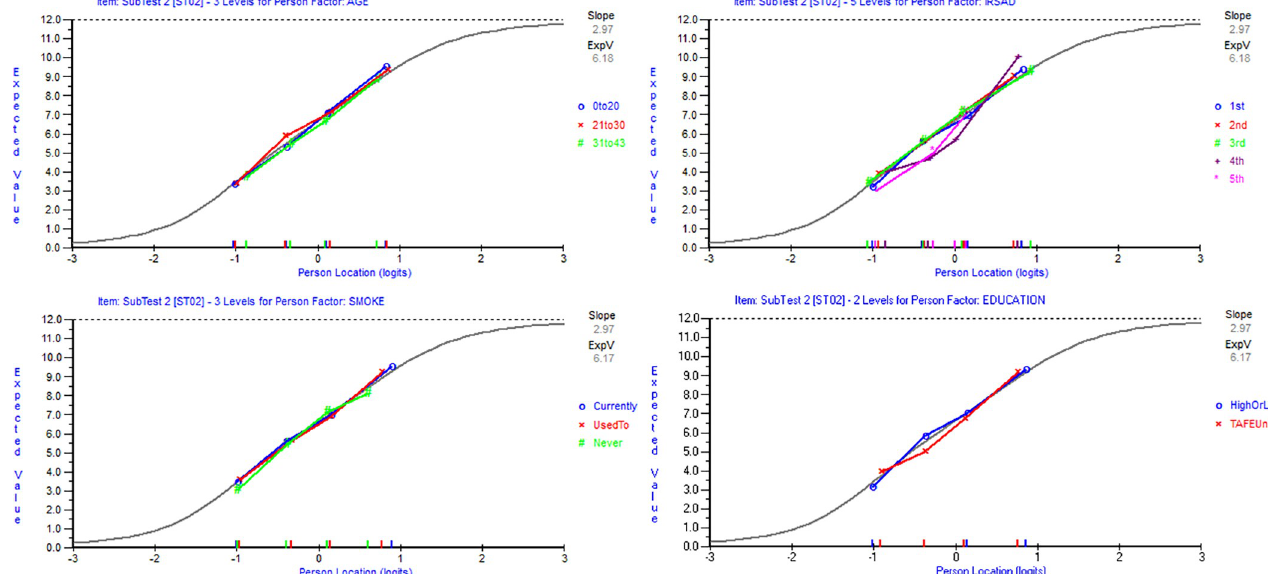
Fig 2. Analysis of Composite Item 2 DIF by Age (upper-left), Socioeconomic position (upper-right), Smoking status (bottom-left) and Education (bottom- right). Note. The colored points indicate the average observed item scores of each subgroup defined by an exogenous variable (e.g. the blue points in the bottom-left graph represent the average item scores of participants who currently smoked, the red points represent the average item scores of participants who used to smoke, and the green points represent the average item scores of participants who never smoked). The grey logistic curve indicates the expected item responses. The slope of the Item Characteristic Curve indicates the rate of change of the expected value with respect to the latent trait at the mid-point between the minimum and maximum